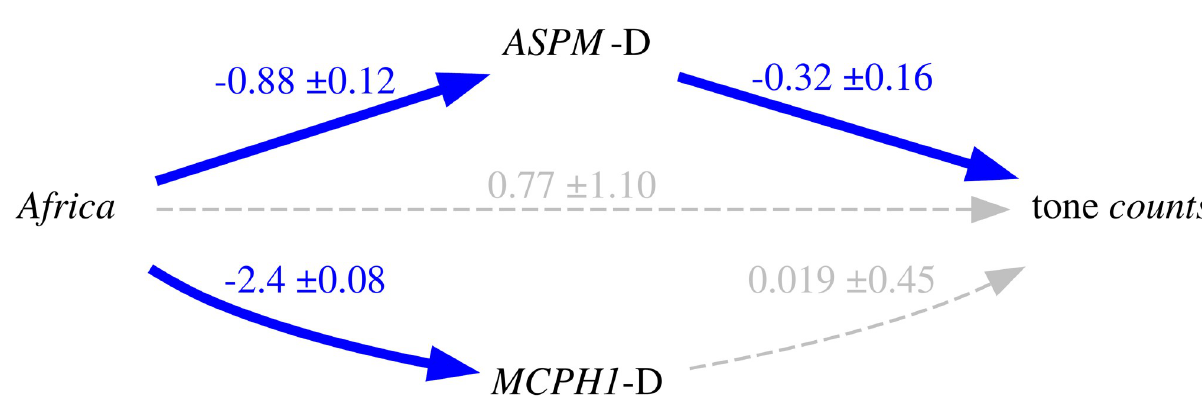
Fig 31. Summary of the 1,000 path models for tone counts fitted to restricted samples. Same conventions as in Fig 14.